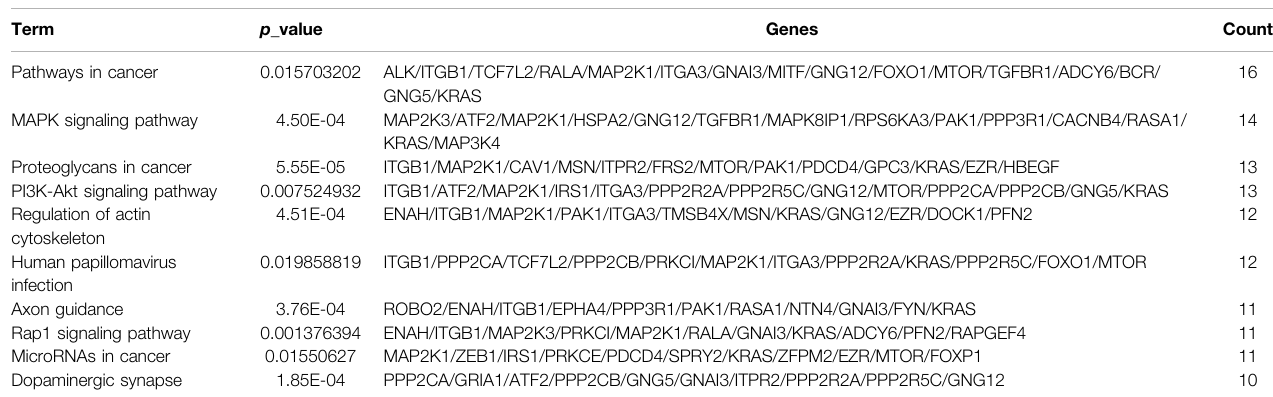
TABLE 6 | KEGG enrichment analysis of upregulated